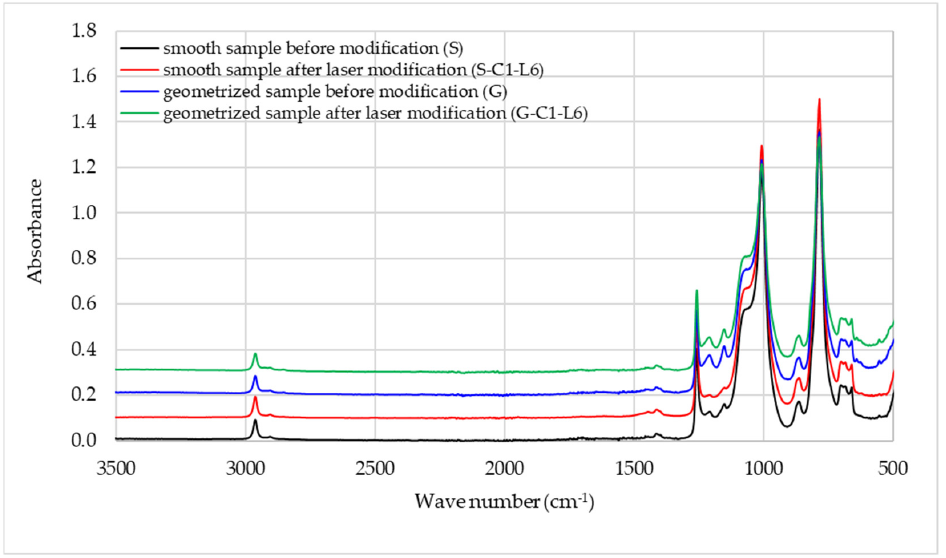
Figure 13. Infrared spectra of smooth and geometrised MVQ vulcanisates before and after laser texturing.